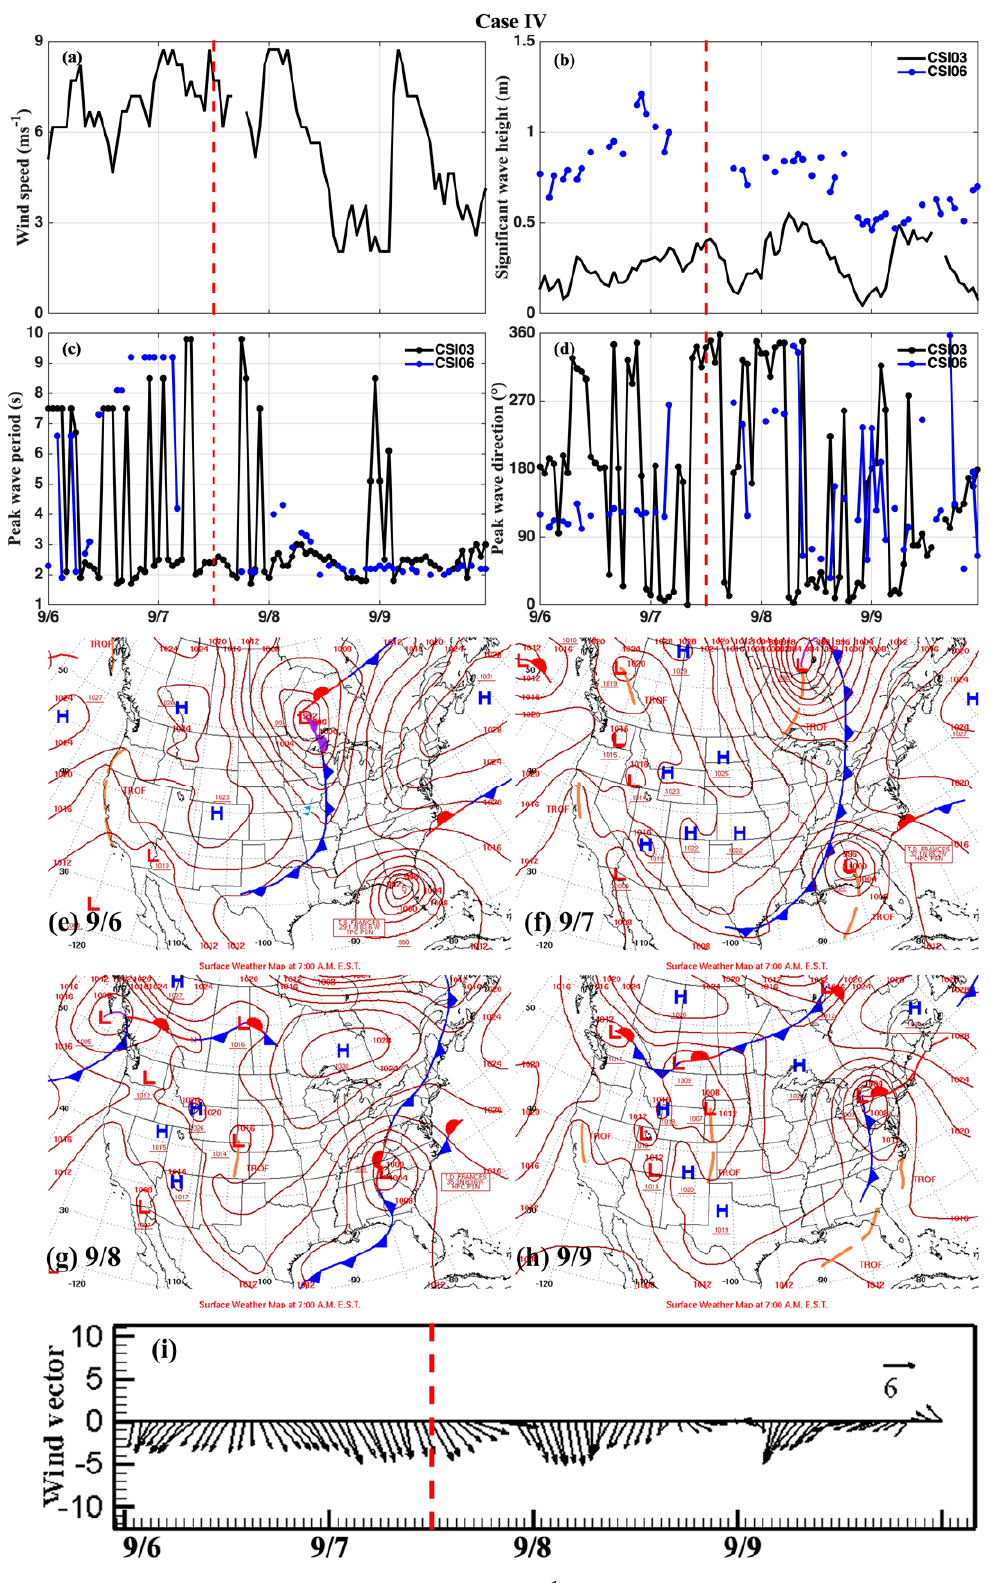
Figure 12. Case IV: Time series of ( a ) wind speed (ms − 1 ), ( b ) significant wave height (m). ( c ) peak wave period (s), ( d ) peak wave direction ( ◦ ), ( e – h ) surface weather map on 12:00 UTC from 6 to 9 September and ( i ) wind vectors from the station WS. The red vertical dashed lines indicate the timing of the cold fronts.